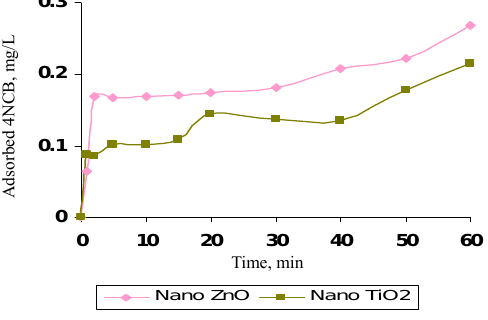
Figure 3. Evolution of the remaining concentration of 4NCB with time during catalytic ozonation by nano TiO pH=